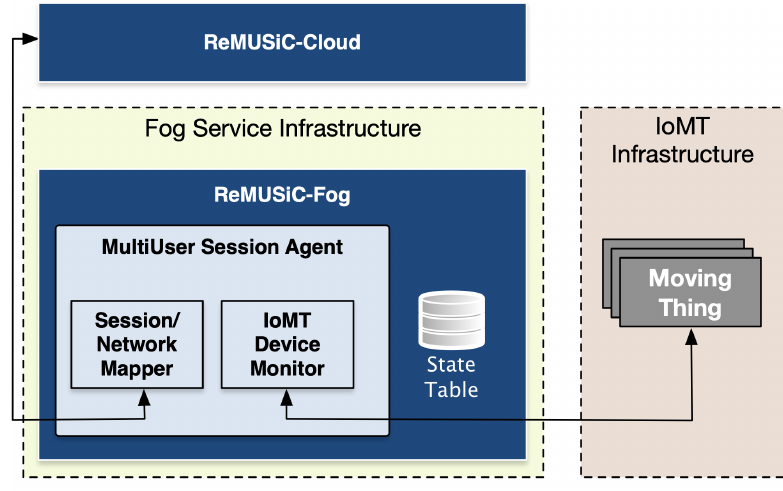
Figure 8. The MultiUser Session Agent (MUSA)